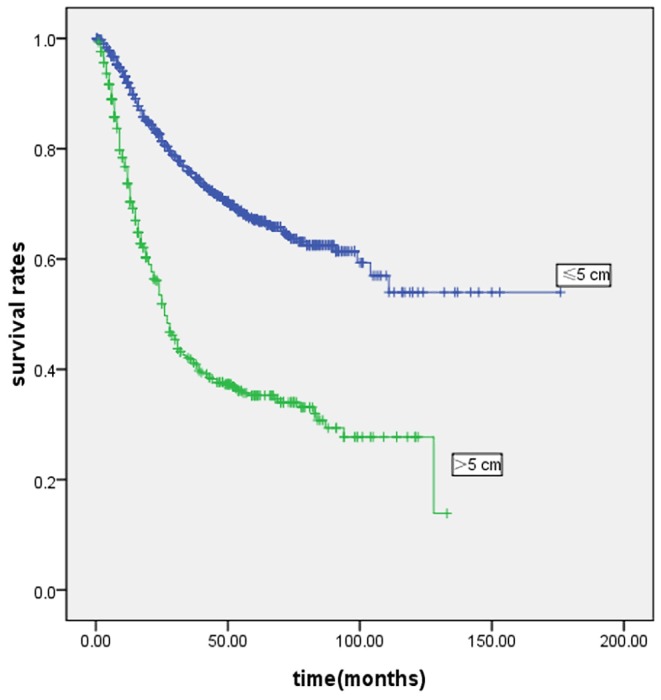
Kaplan-Meier survival curves in curative gastrectomy patients according to tumor size (n = 1320).Prognosis of larger tumor size was worse than smaller tumor size in patients with gastric cancer(P<0·001). Five-year survival rates were 44.0% and 70.7% in LSG and SSG, respectively.